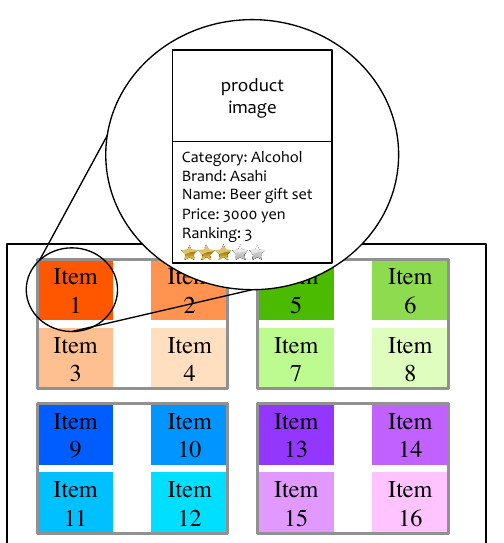
Figure 2 . Layout of digital catalogs. Items with a same color hue are in a same group, and each group of items are divided by a gray frame.